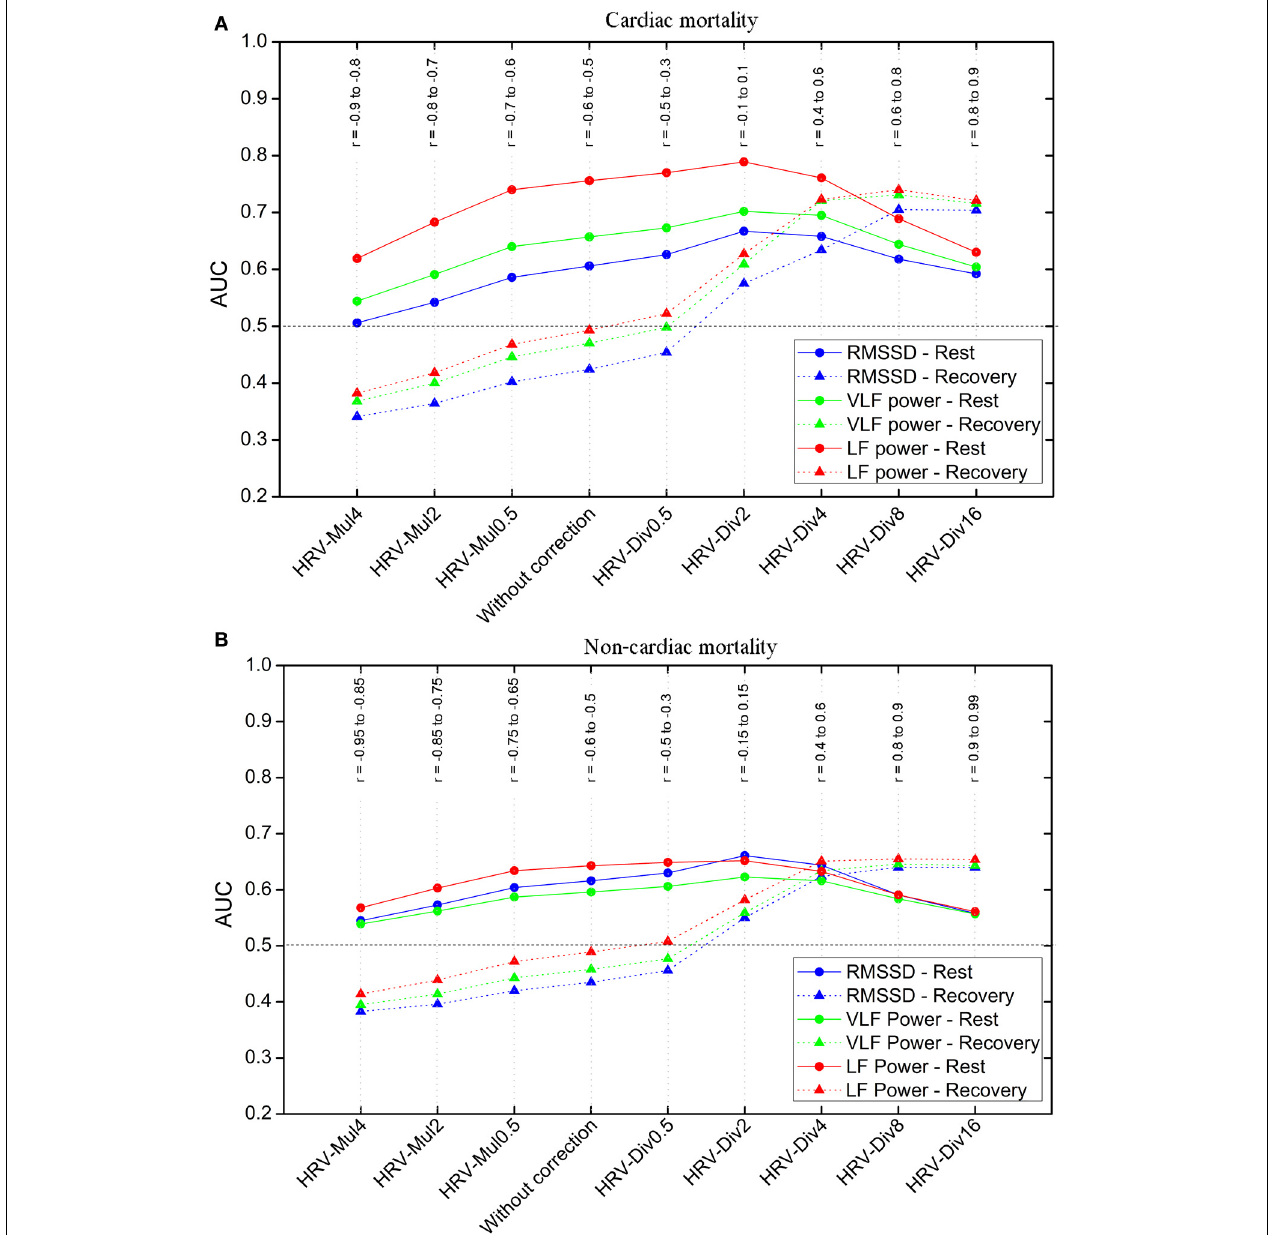
FIGURE 1 | Predictive performance of heart rate variability (HRV) parameters for: (A) cardiac mortality and (B) non-cardiac mortality groups. Area under the receiver operating characteristics curves (AUC) and correlation coefficients (r), between HRV parameters and HR, for different